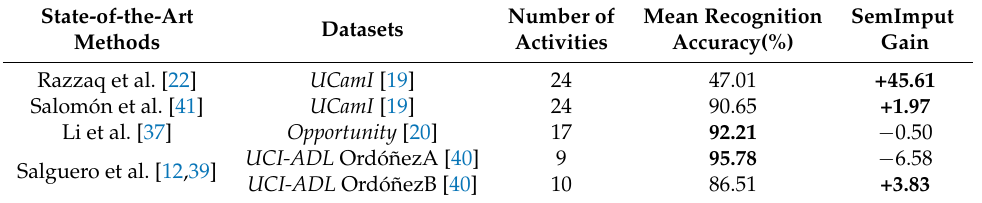
Table 7. Comparison results of the proposed SemImput framework with state-of-the-art HAR